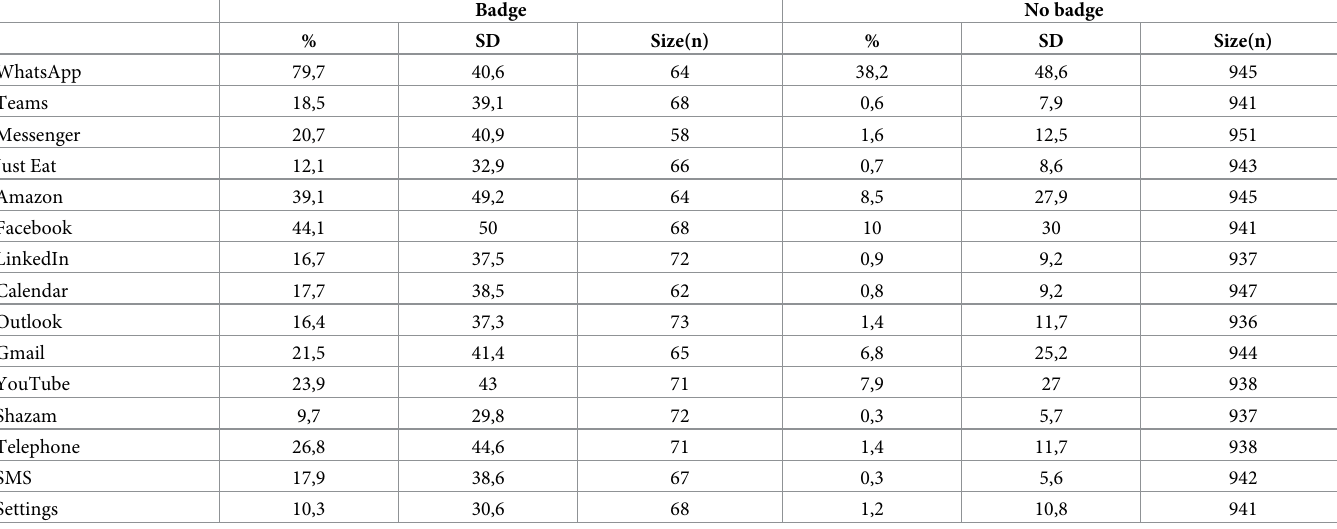
Table 1. Means, standard deviations and sample sizes for each of the experimental